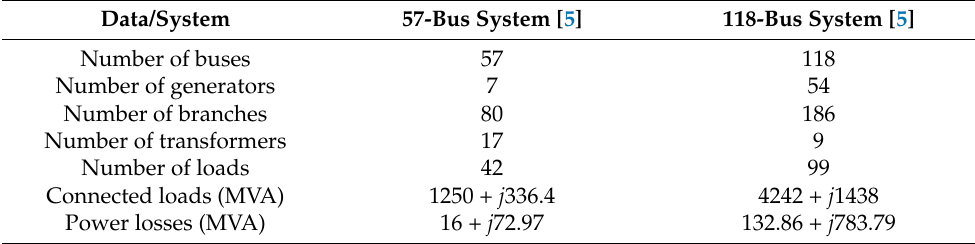
Table 1. Data of the two studied systems.